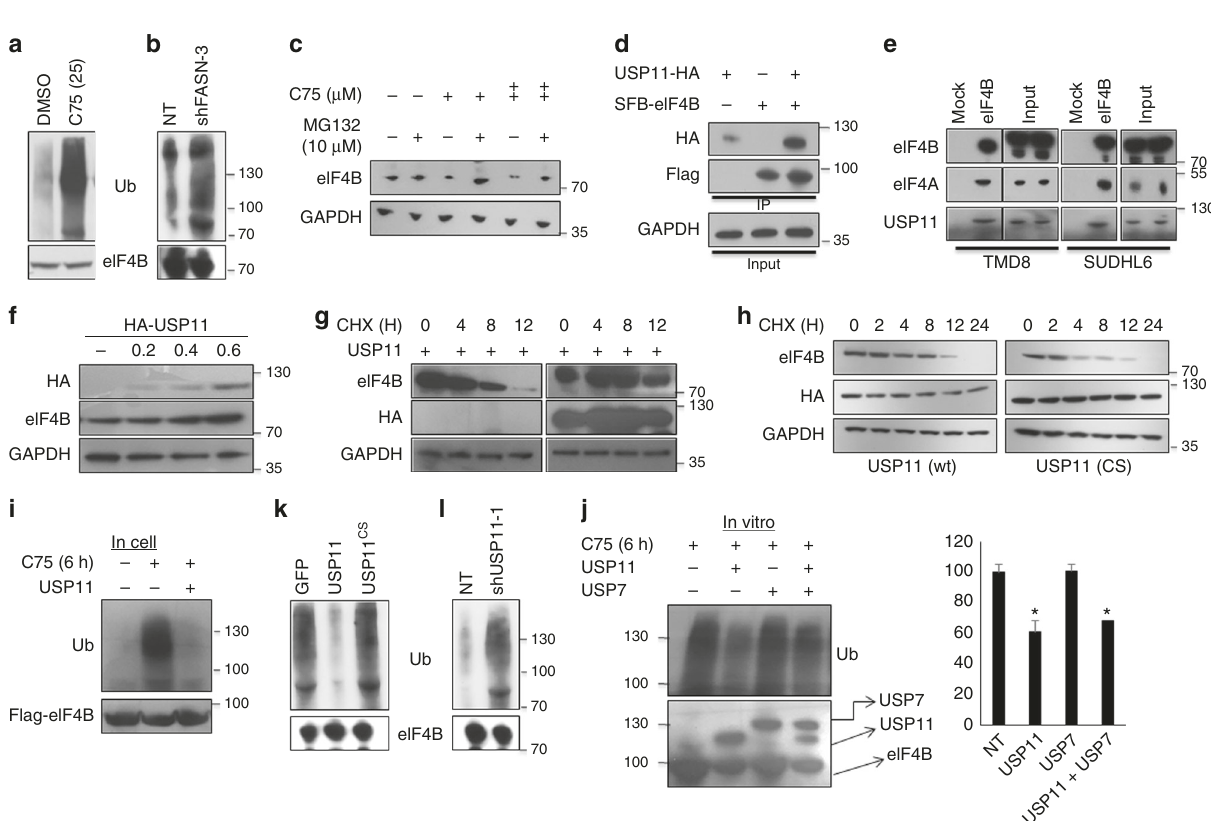
Figure 14D). In order to decipher potential regulatory molecules